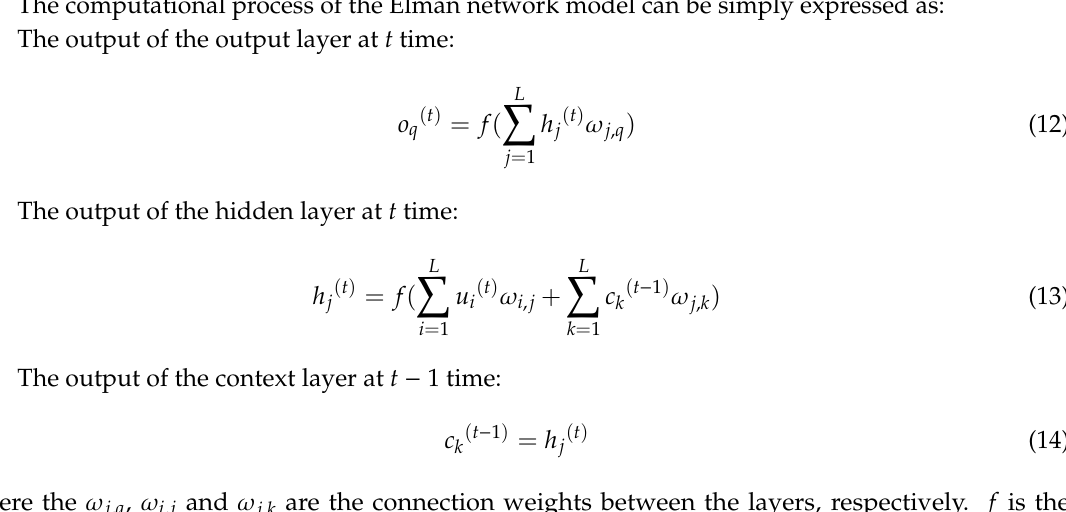
Figure 2. Structure of the Elman Neural Network.